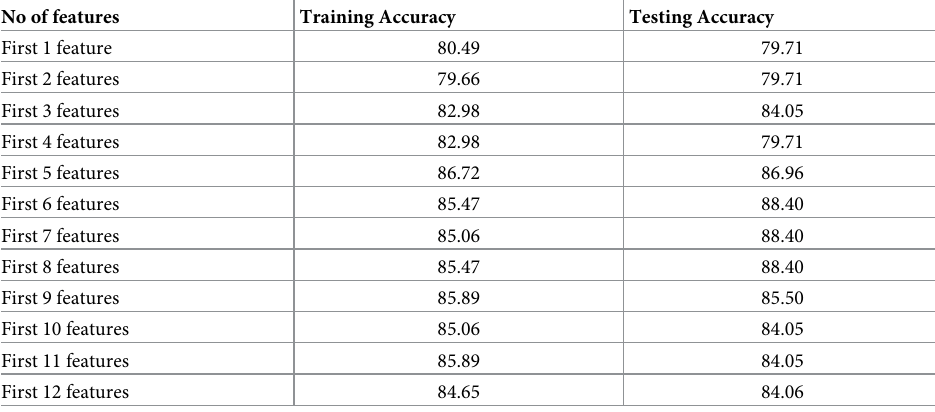
Table 9. Training and testing accuracies for bagging SVM with different number of features.